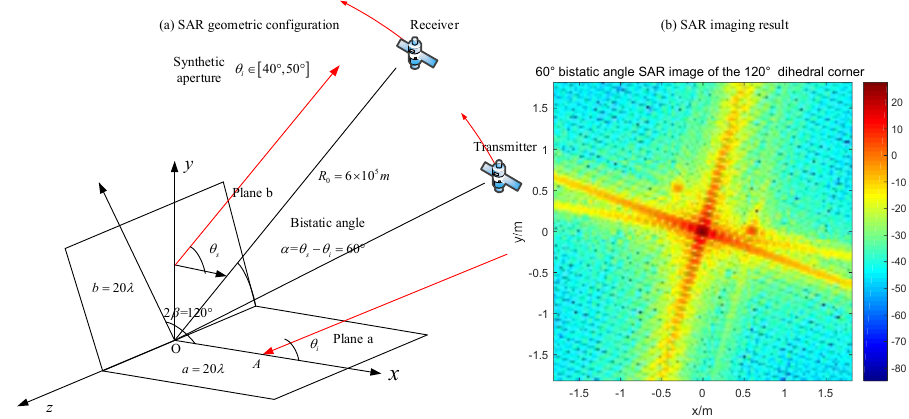
Figure 23. Bistatic SAR with 60 ◦ bistatic angle image of the 120 ◦ obtuse dihedral angle ( a ) geometric configuration; ( b ) imaging result.